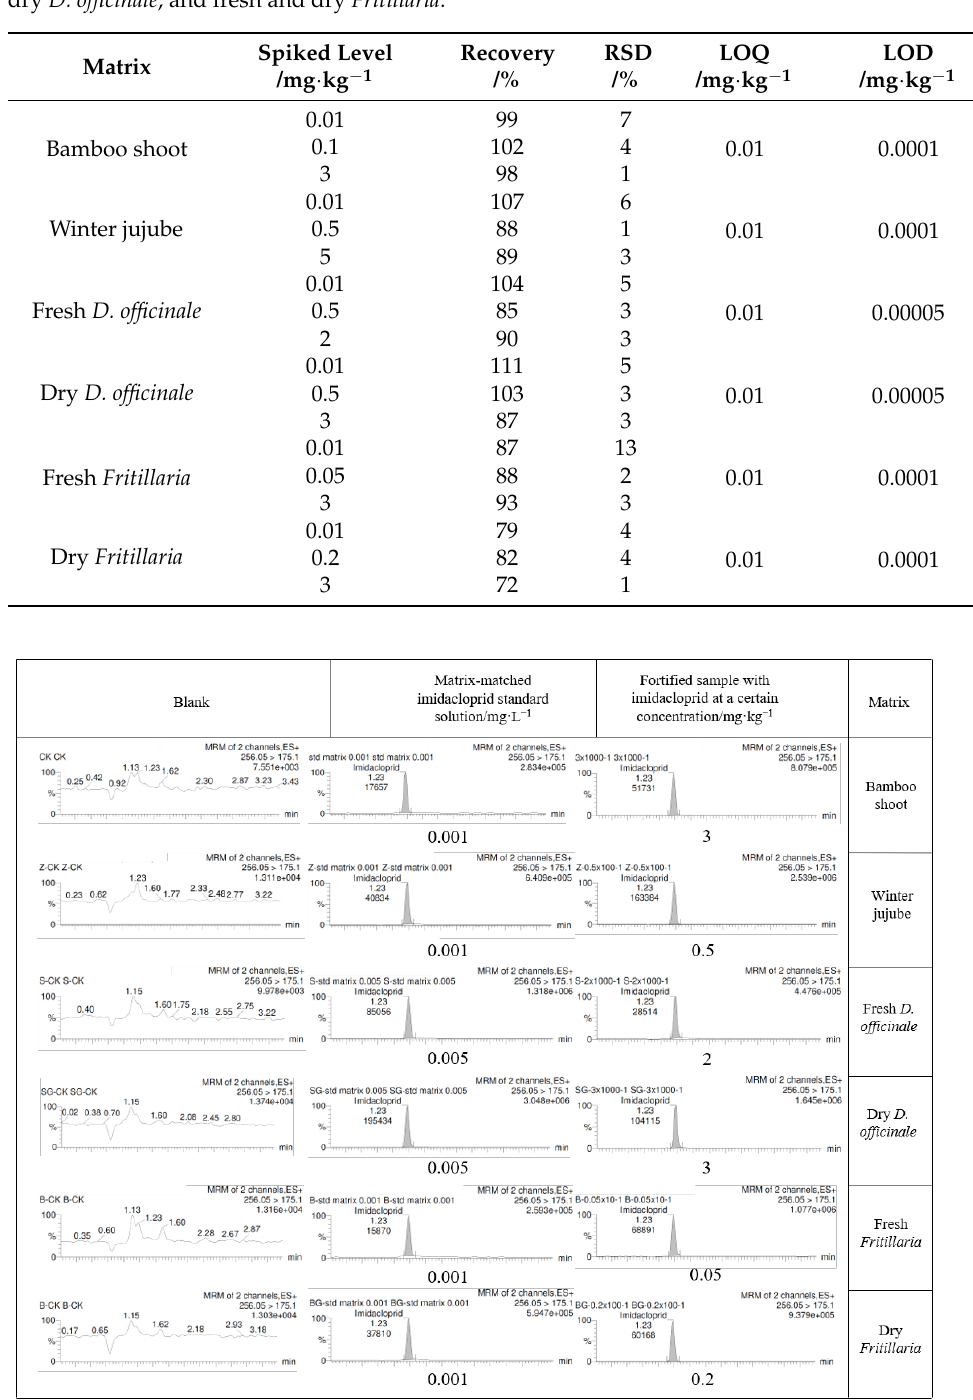
Figure 2. Representative chromatograms of imidacloprid in bamboo shoot, winter jujube, fresh and dry D. officinale , and fresh and dry Fritillaria (horizontal row) of blank, matrix-matched imidaclo- prid standard solution, and fortified samples with imidacloprid at certain concentration/mg · kg − 1 (vertical